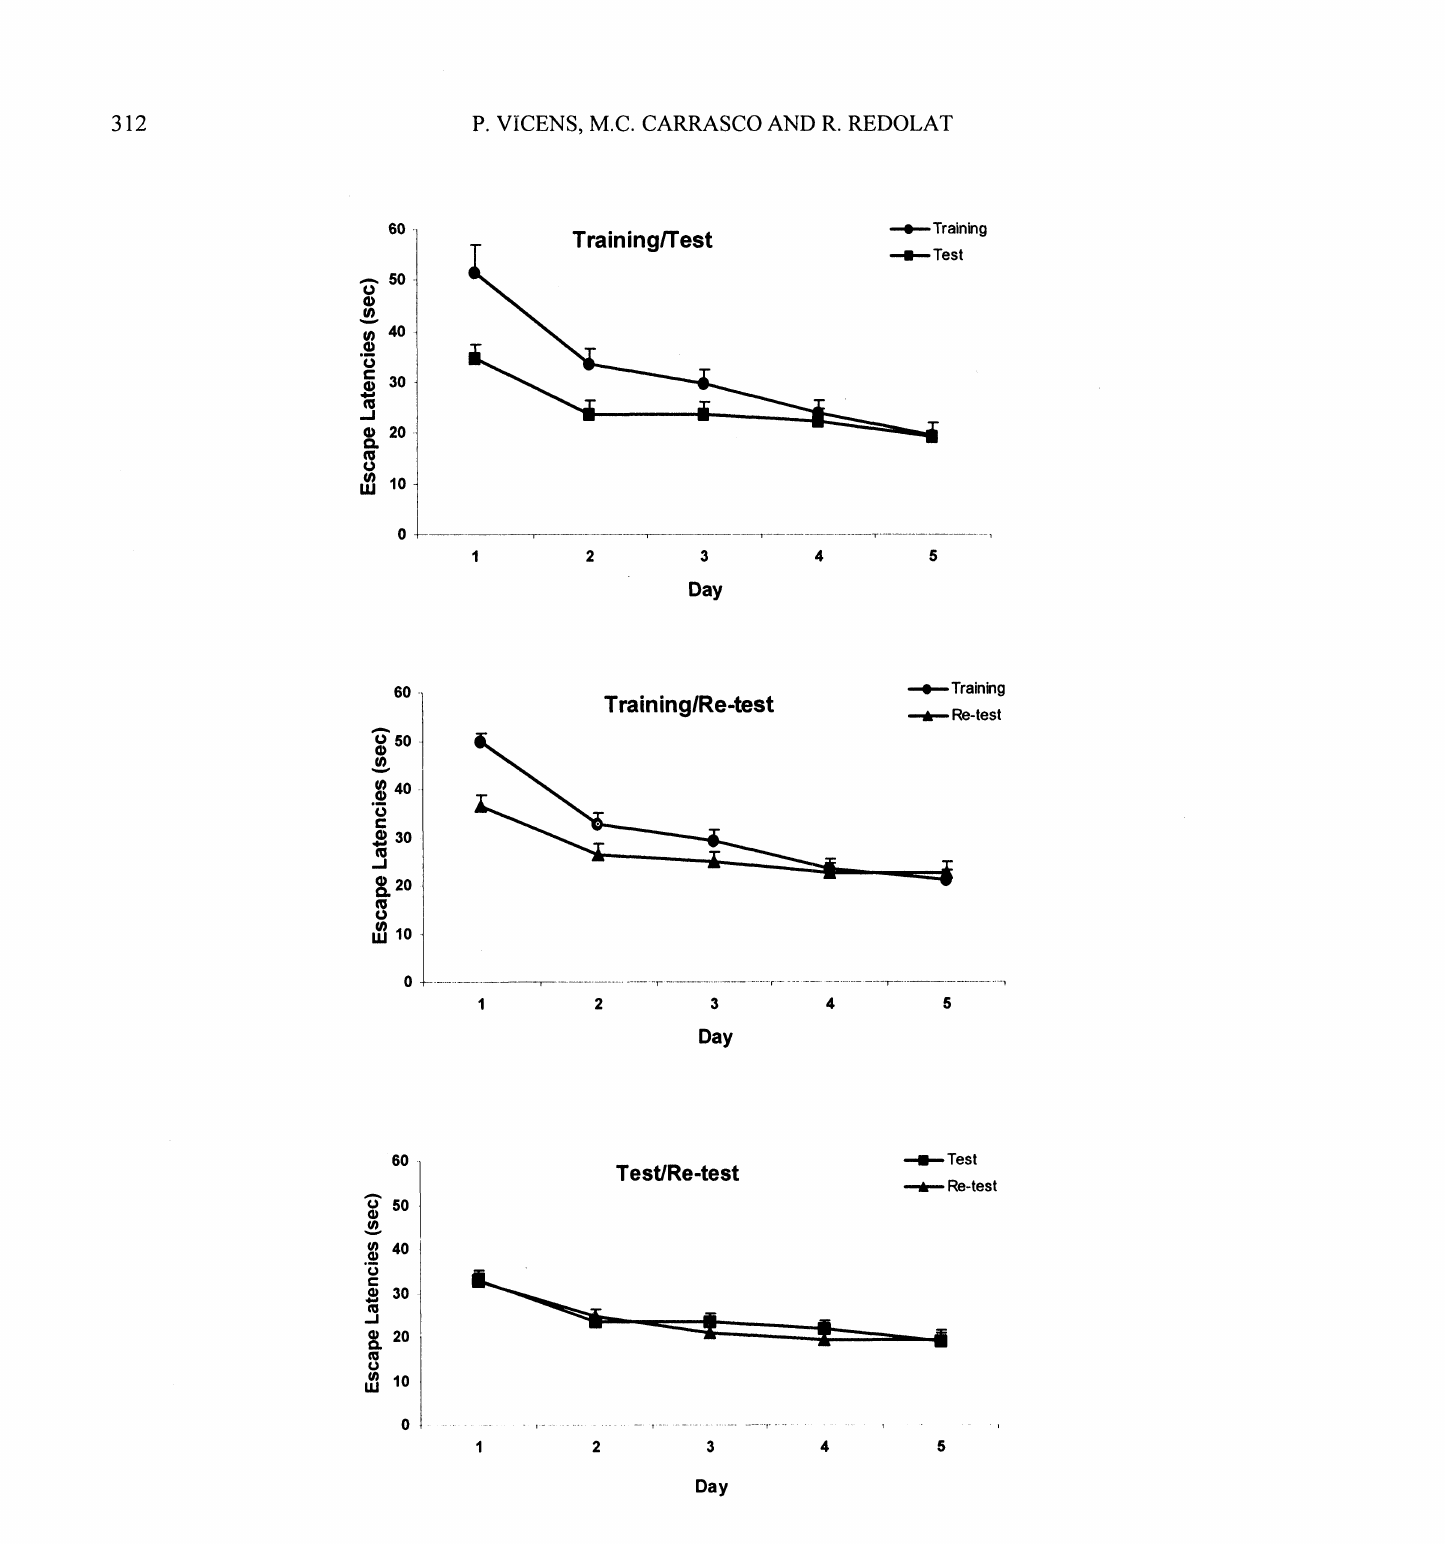
Fig. 4: Comparisons between the mean (+ SEM) daily escape latencies (averaged over four trials/day) of all groups tested at 2 months of age (training phase), 6 months of age (test phase) and 10 months of age (re-test